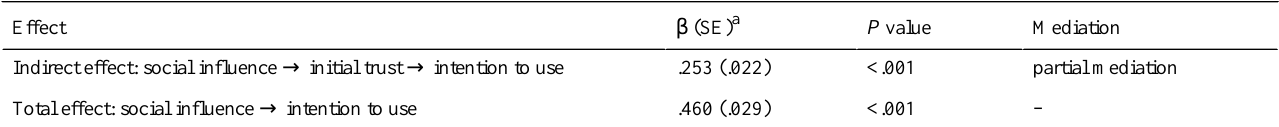
Table 5. Mediating